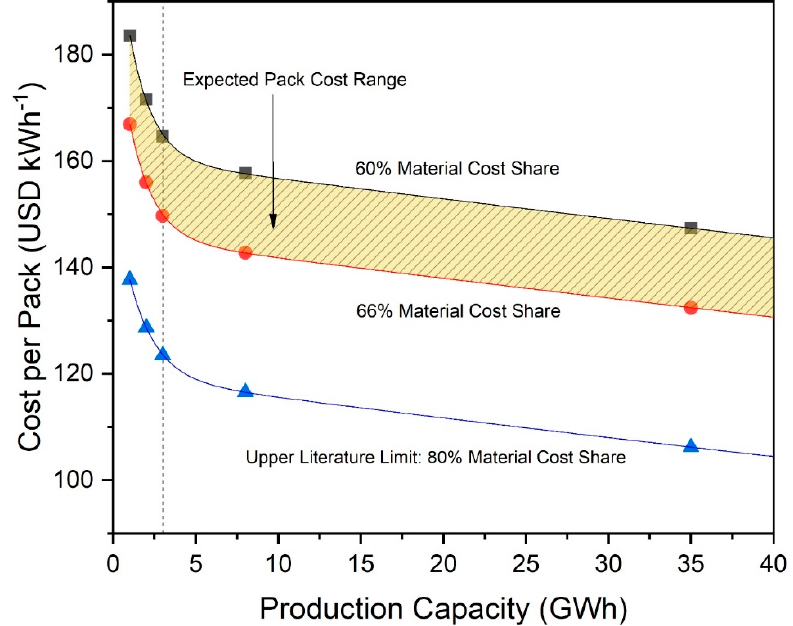
Figure 7. Cost per battery pack for batteries based on NCA//Gr cell chemistry as a function of factory production capacity, with curves representing 60, 66, and 80% share, respectively, material cost. Dotted line indicates 3 GWh, the point at which process-based economy of scale effects reach their maximum.